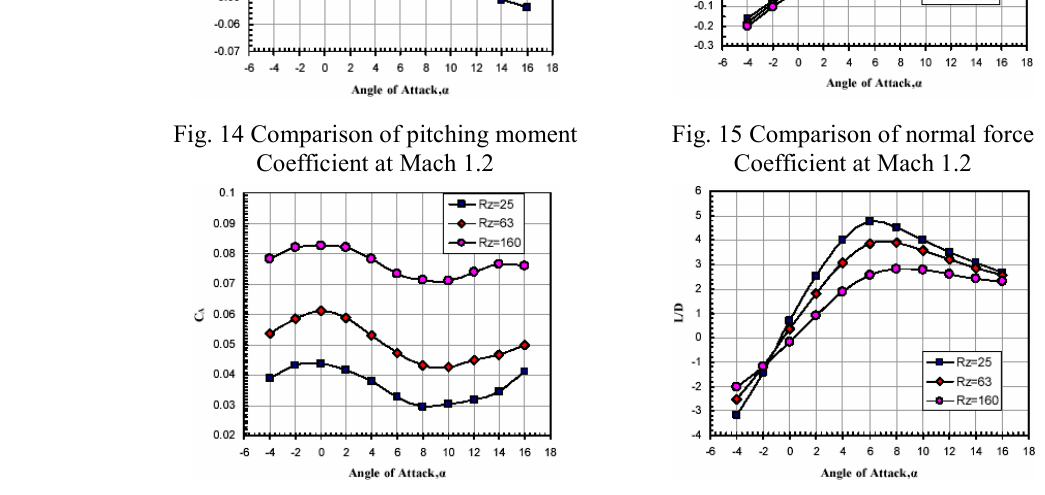
F ig.17 Comparison of lift over drag at Mach